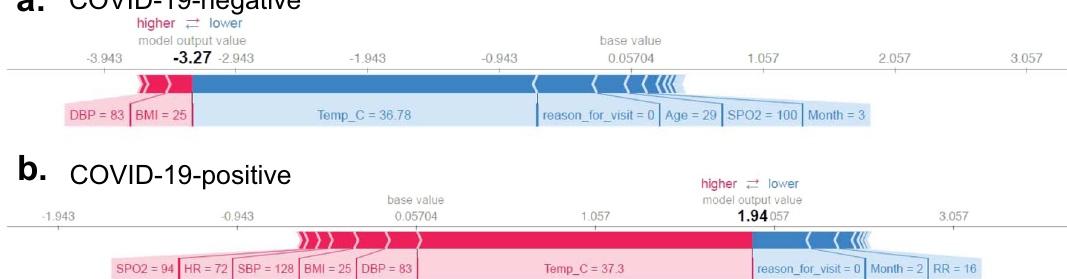
Fig. 5 SHapley Additive exPlanations (SHAP) force or explanation plots of COVID-19-positive and -negative patient encounters. Sample observations from two patient encounters with a COVID-19-negative and b COVID-19-positive predictions. Features that are contributing to a higher and lower SHAP values are shown in red and blue, respectively, along with the size of each feature ’ s contribution to the model ’ s output. The baseline — the mean of the model output (log-odds) over the training dataset — is 0.057 (translating to a probability value of 0.5143). The fi rst patient — who is COVID-19 negative — has a low predicted risk score of − 3.27 (output probability = 0.0366). The second patient — who is COVID-19 positive — has a high predicted risk of 1.94 (output probability = 0.8744). These SHAP output values represent a “ raw ” log-odds value which is transformed into a probability space, to provide the fi nal output of 0 and 1 (<0.5 and >0.5). Risk increasing effects such as Temp, SpO 2 , HR, and BP were offset by decreasing effects of RR in pushing the model ’ s predictions towards or away from the positive class,